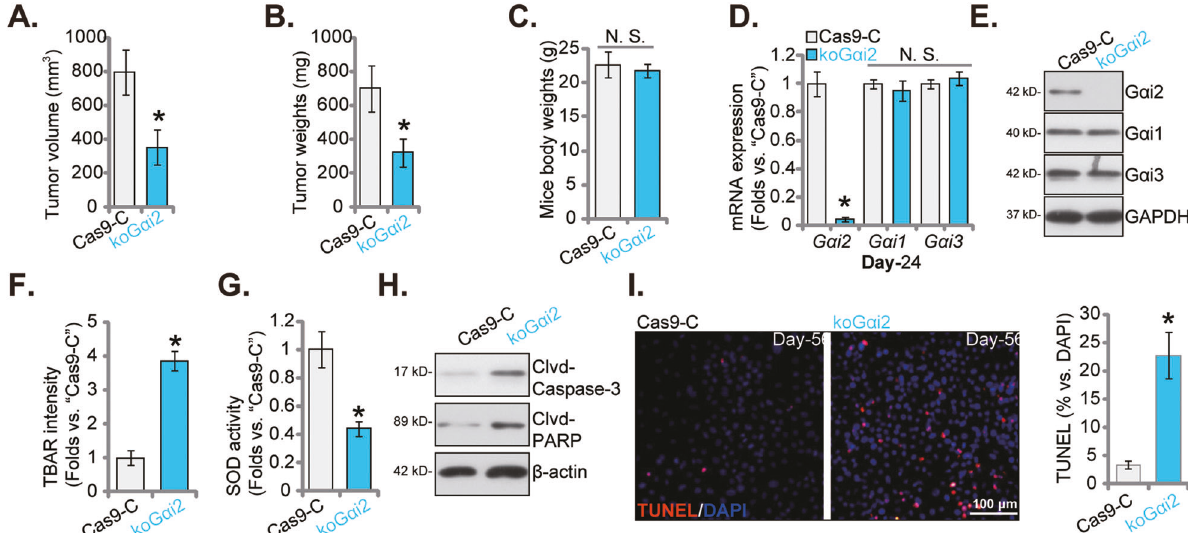
Fig. 9 G α i2 KO hinders HCC cell growth in vivo. pHCC1 cells with the G α i2 sgRNA1-expressing lenti-CRISPR/dCas9-KO-puro construct ( “ koG α i2 ” ) or the lenti-CRISPR/dCas9-KO-puro construct ( “ Cas9-C ” ) were s.c . injected to fl anks of the nude mice at 1 × 10 7 cells per xenograft. There were six mice in each group. After seven weeks, the xenografts were isolated, tumor volumes ( A ), tumor weights ( B ) and animal body weights ( C ) were measured. pHCC1 cell xenografts were homogenized, and listed genes and proteins in the tissue lysates tested ( D , E, and H ). The TBAR intensity ( F ) and the SOD activity ( G ) in the xenograft tissues were examined. The representative TUNEL fl uorescence images in the described pHCC1 xenograft slides were presented ( I ). The data were presented as mean ± standard deviation (SD, n = 6). * P < 0.05 versus “ Cas9-C ” group. “ N. S. ” stands for non-statistical difference ( P > 0.05). Scale bar = 100 μ